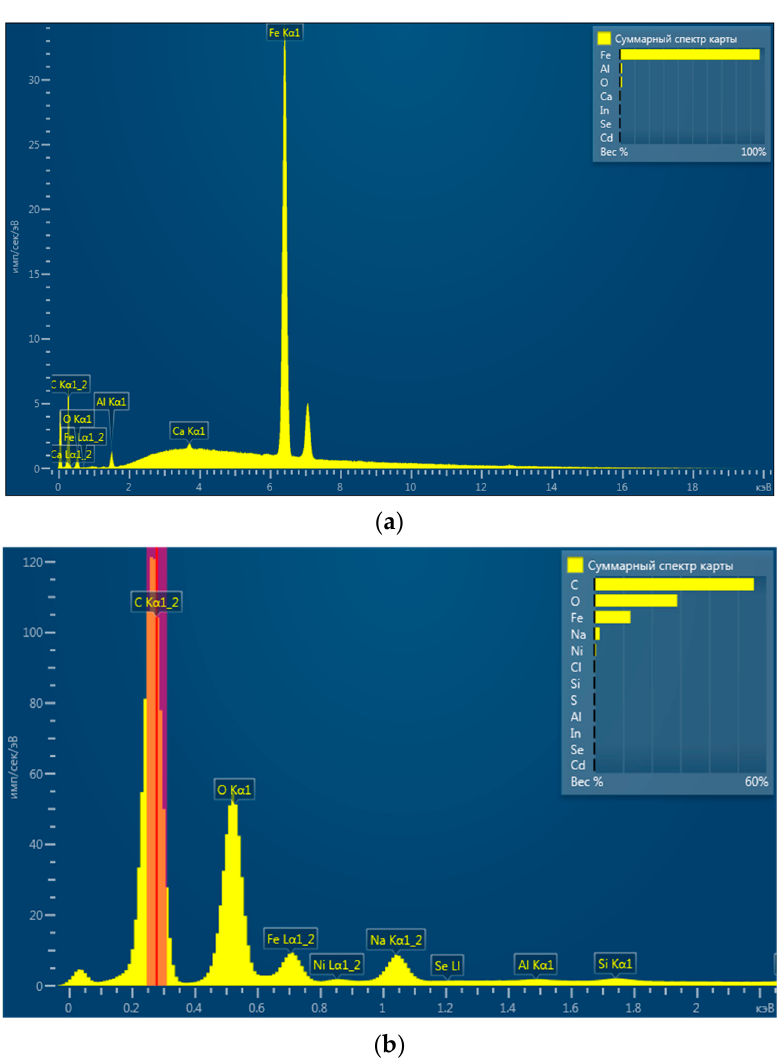
Figure 2. EDS spectra of nZVI nanoparticles ( a ) and 0.5% Ni loading Fe/Ni bimetallic nanoparticles ( b ).